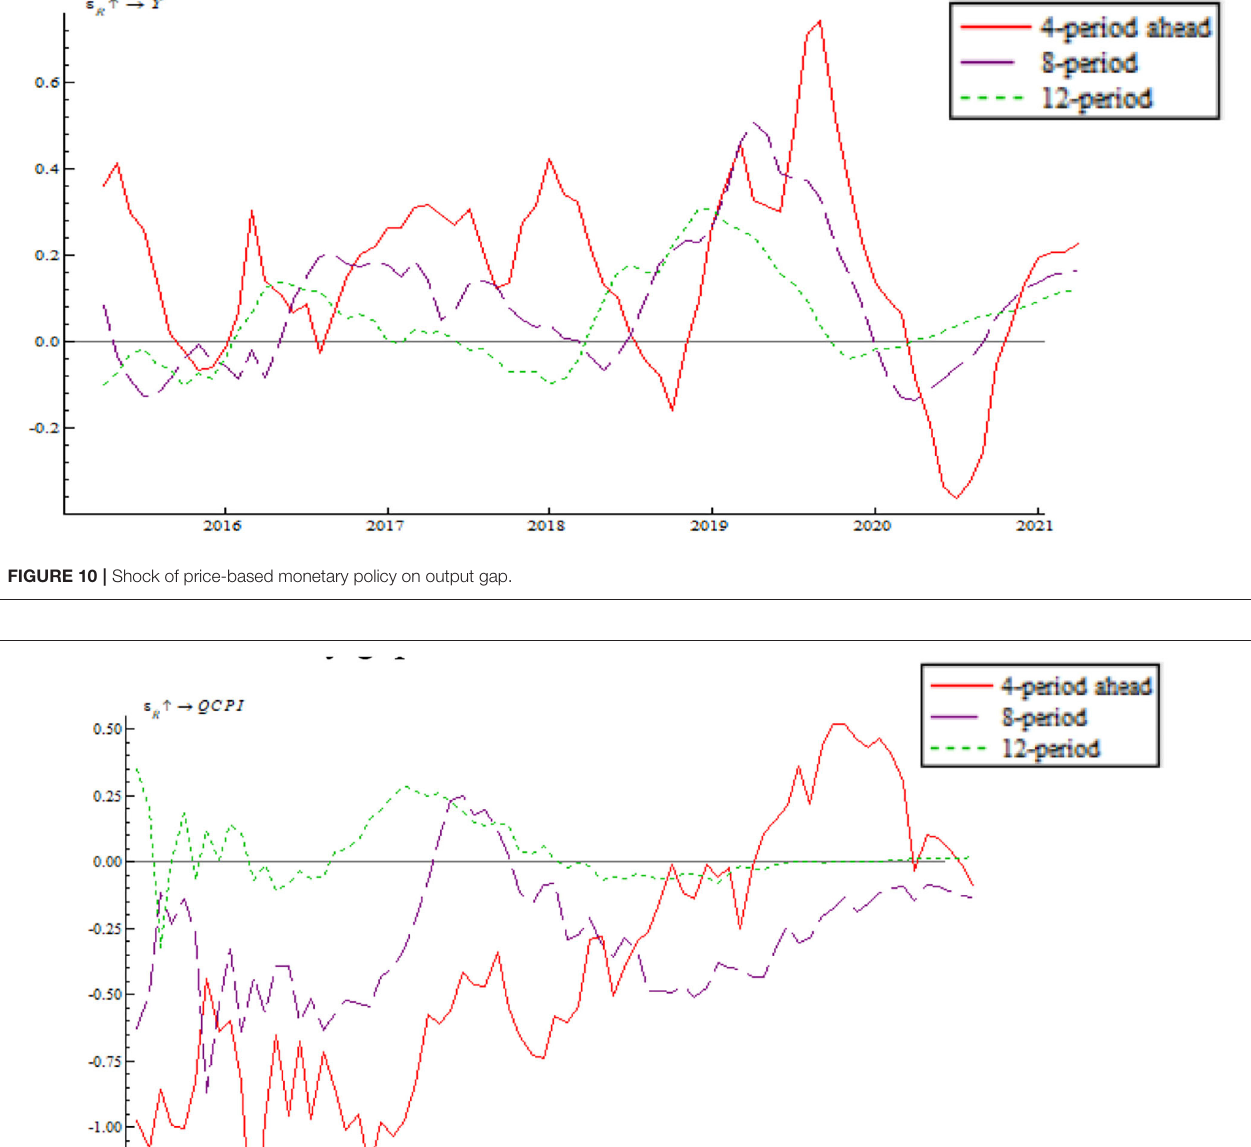
As shown Figure 10 , the shock of price-based monetary policy on output gap assumes a W-shape trend which fluctuates around the zero line, which indicates that the central bank can make counter-cyclical adjustment using the price-based monetary policy instrument. In response to the negative output gap resulting from the China-U.S. trade war in 2018, the central bank implemented multiple rounds of reduction in the